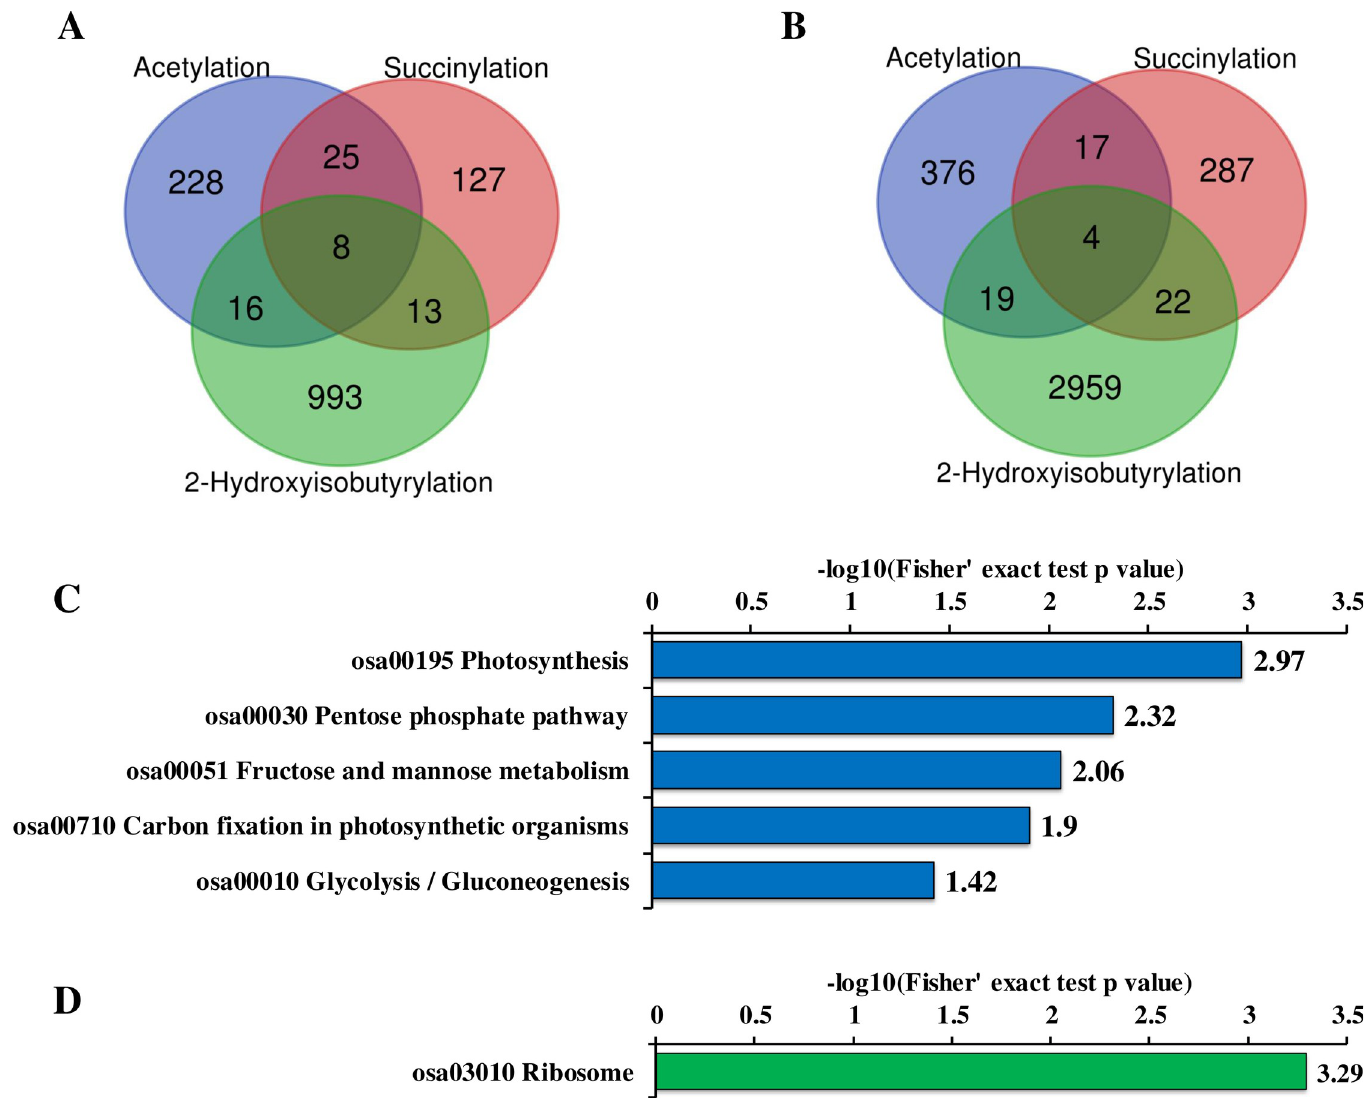
Fig 7. Overlap analyses among wheat acetylome, succinylome and 2-hydroxyisobutyrylome. (A) Overlap of Kac, Ksucc and Khib proteins. (B) Overlap of Kac, Ksucc and Khib sites. (C) KEGG pathways enrichment of the overlapped proteins between Kac and Khib. (D) KEGG pathways enrichment of the overlapped proteins between Ksucc and